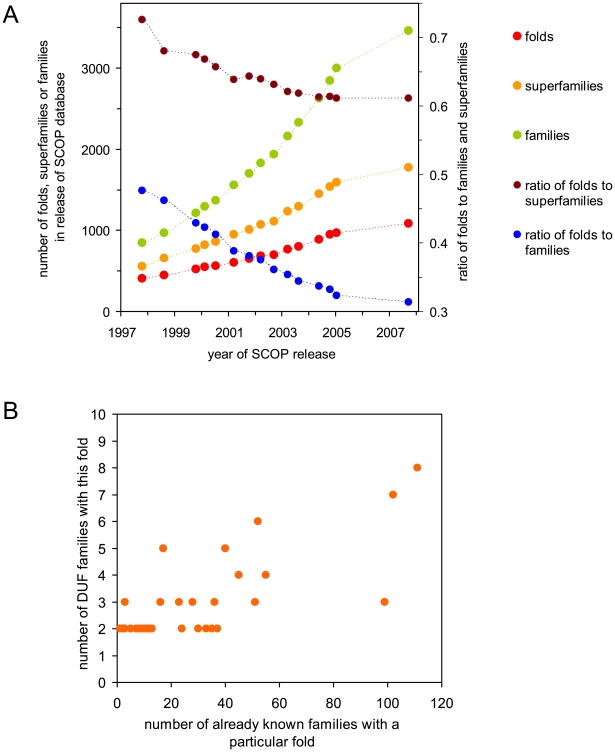
Analysis of trends in families, superfamilies, and DUFs.(A) Long-term trends in the proportion of protein folds to protein families and to protein superfamilies according to SCOP database. Each point corresponds to one release SCOP database (n.b., there were no SCOP releases between January 2005 and September 2007). This analysis is based on the data available from the SCOP website (http://scop.mrc-lmb.cam.ac.uk/scop/). (B) Number of fold representatives in DUF families as a function of a number of already known families with the same fold (n.b., the number of known families of the same fold was derived from the SCOP database).